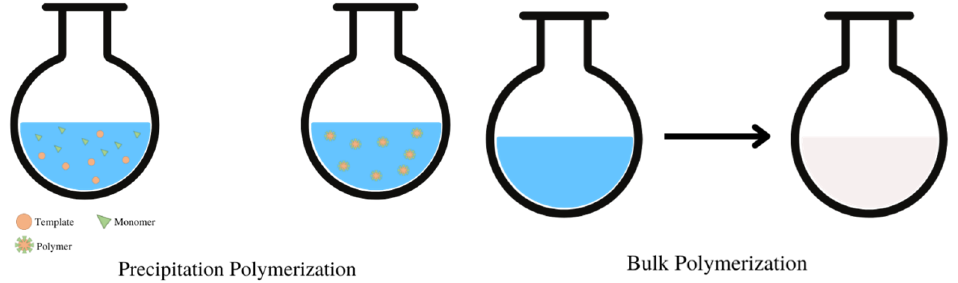
Figure 1. Illustration of the precipitation polymerization method ( left ) and bulk polymerization method ( right ).